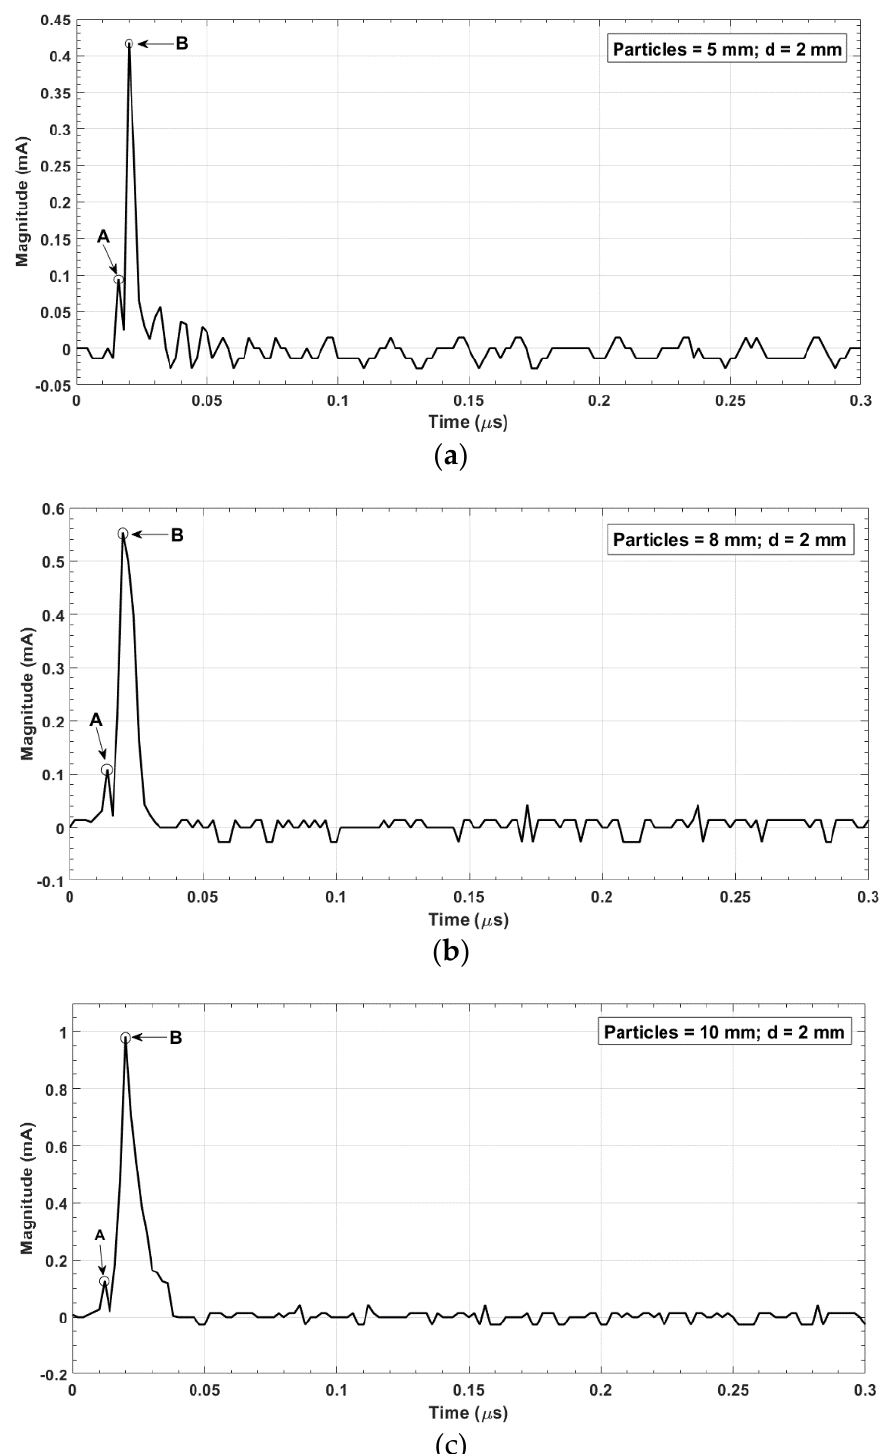
Figure 9. Inception currents ( a ) 5 mm particles, ( b ) 8 mm particles, and ( c ) 10 mm particles with d = 2 mm.